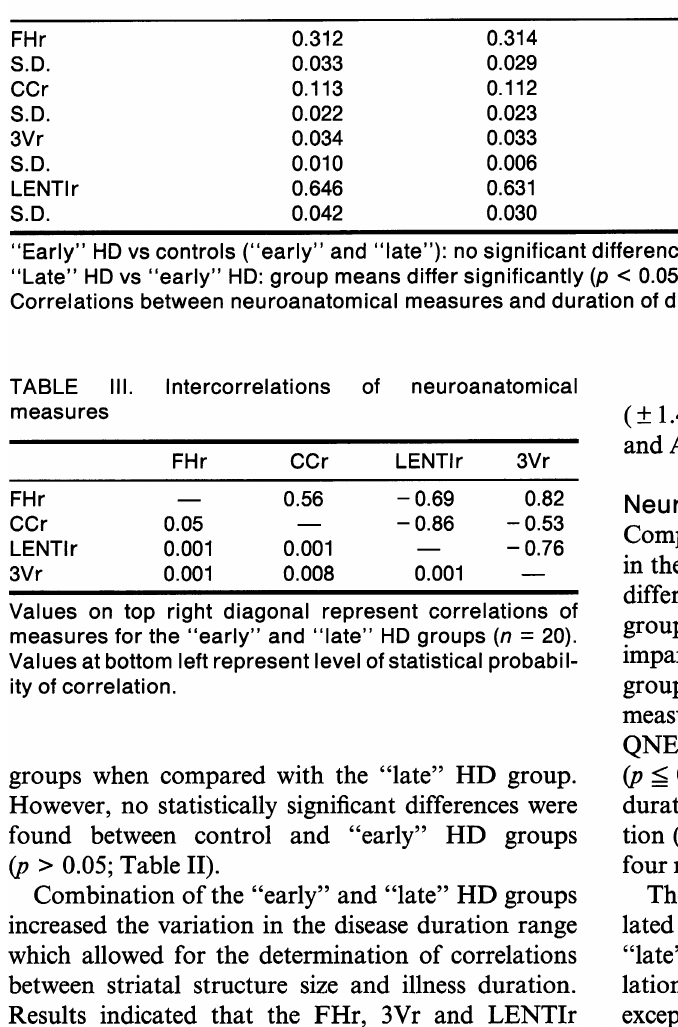
illness duration